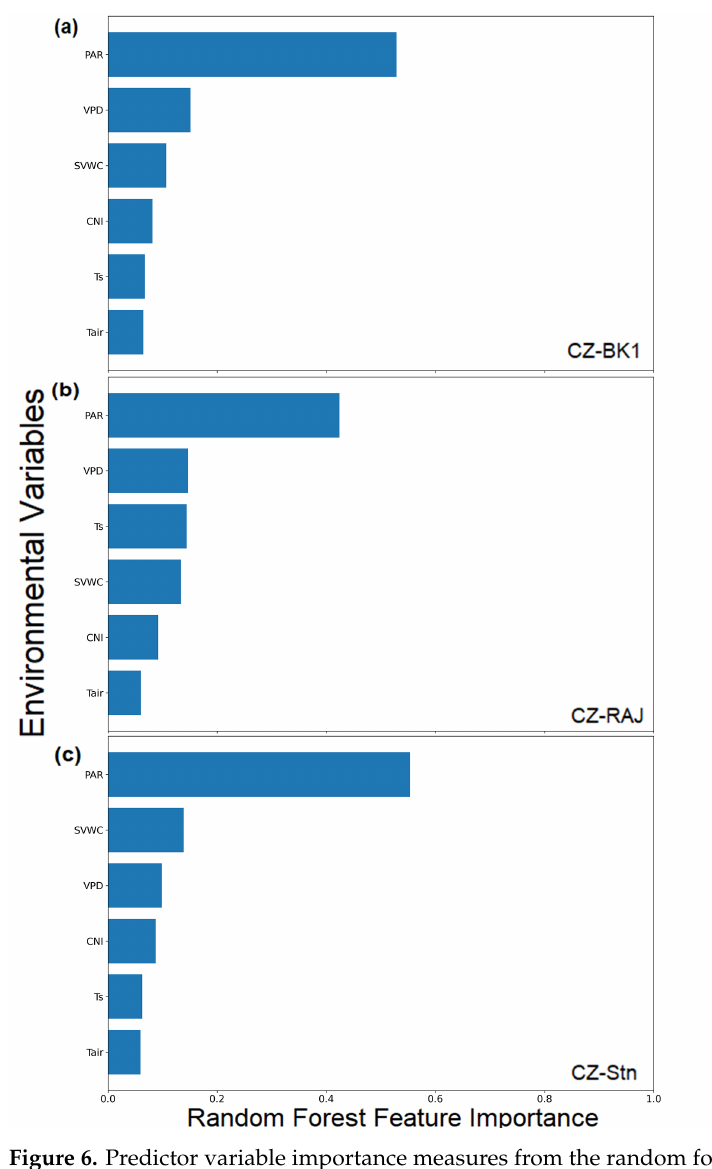
Figure 6. Predictor variable importance measures from the random forest analyses for ( a ) the wet spruce forest in Bílý K˘rí˘z (CZ-BK1), ( b ) the dry spruce forest in Rájec (CZ-RAJ), and ( c ) the beech forest in Štítná (CZ-Stn). CNI: clearness index; PAR: photosynthetic available radiation; T air : air temperature; T s : soil temperature; SVWC: the soil volumetric water content; and VPD: vapour pressure